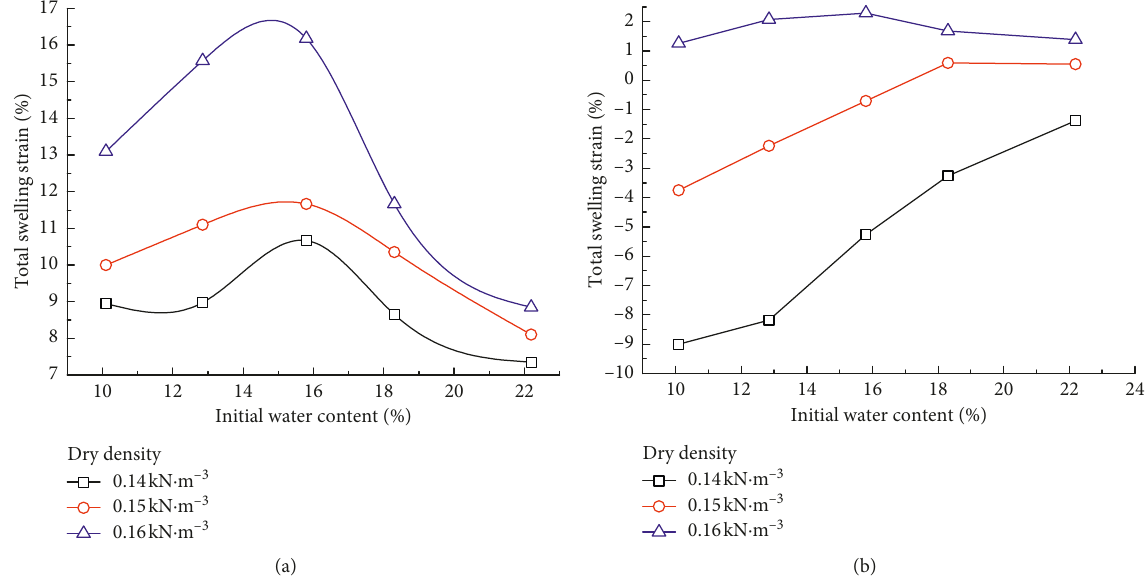
Figure 10: Relation of expansive strain and moisture content for diverse axial pressure. (a) Axial pressure of 0kPa. (b) Axial pressure of